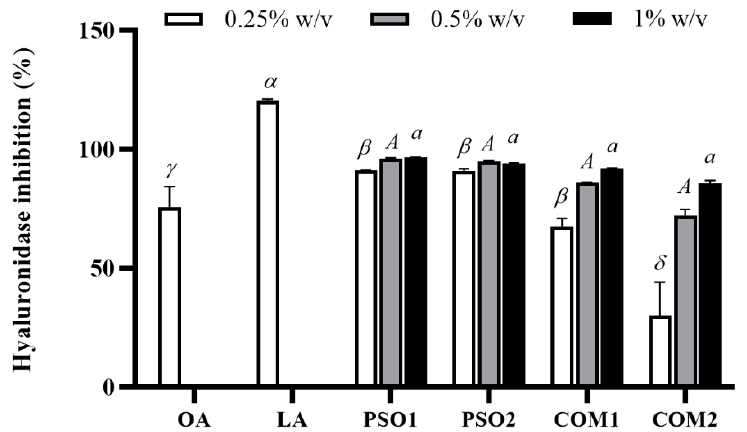
Figure 5. Hyaluronidase inhibitory effect of pumpkin seed oil samples (PSO1, PSO2, COM1, COM2), linoleic acid (LA), and oleanolic acid (OA). Data obtained from triplicate and three independent experiments are expressed as mean ± SD. The symbols, α , β , γ , and δ , present significant differences among samples at the concentration of 0.25% w / v . The capital letter, A , presents no significant difference among samples at the concentration of 0.5% w / v . The letter, a , presents no significant differences among samples in at the concentration of 1% w / v , p < 0.05.